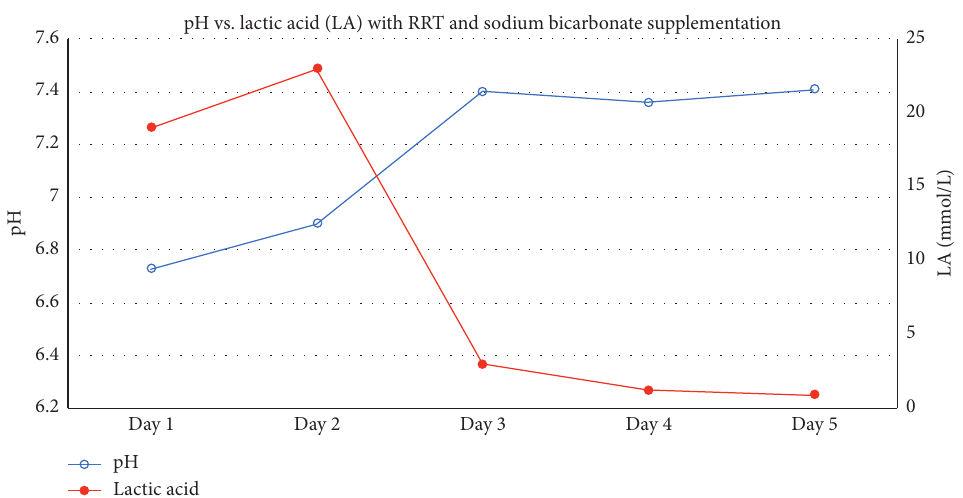
Figure 2: pH vs. lactic acid (LA) with RRT and sodium bicarbonate